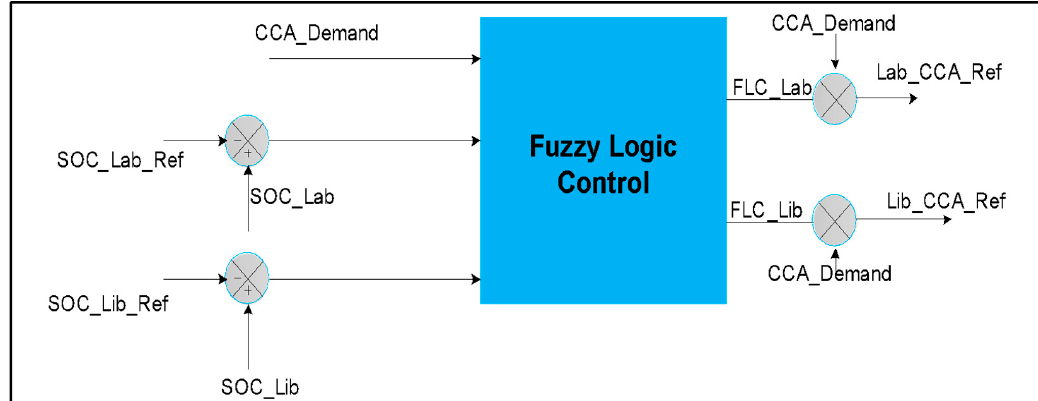
Figure 7. FLC block diagram strategy.